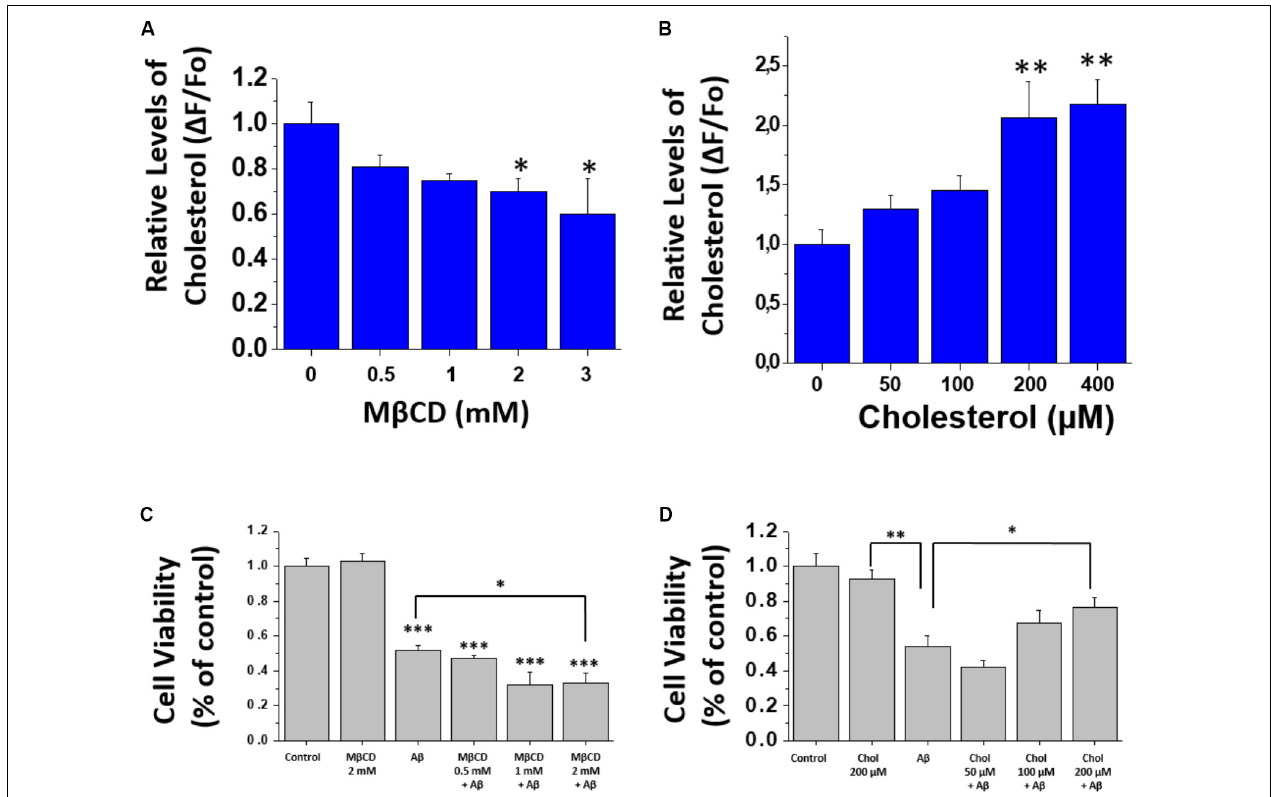
FIGURE 1 | Modification of cholesterol levels in hippocampal neurons. (A,B) Quantification of filipin III fluorescence showing relative levels of cholesterol after treatment with M β CD (0.5–3 mM), and after treatment with different concentrations of soluble cholesterol (0–400 µ M) in hippocampal neurons. (C,D) Cell viability assay performed after treatments to modify membrane-cholesterol and subsequent A β incubation (1 µ M for 24 h). The bars represent the mean ± SEM. Asterisks denote: ∗ p < 0.05, ∗∗ p < 0.005, ∗∗∗ p <